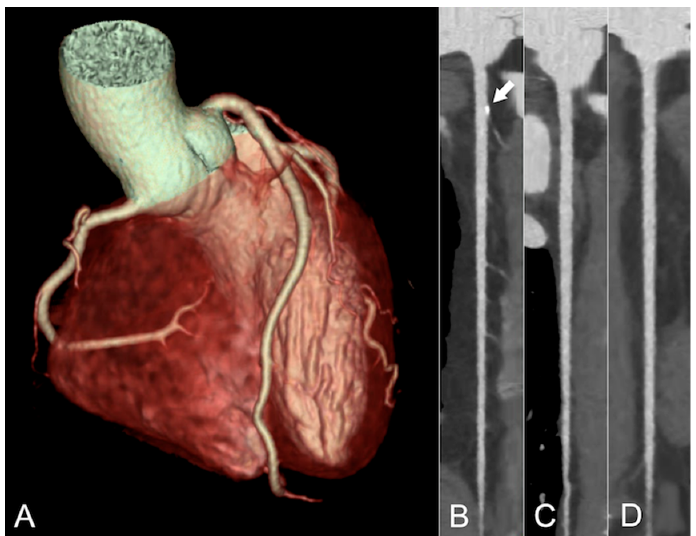
Figure 2. Coronary computed tomography angiography of a 48-year old HIV+ female patient with typical angina. The patient had a positive family history for cardiovascular events and was an active smoker, putting her at intermediate risk for having coronary artery disease. Volume rendering ( A ) of the image datasets depicts normal coronary anatomy, while the curved multiplanar reformats of the left anterior descending ( B ), the left circumflex ( C ), and the right coronary ( D ) arteries reveal only minimal and non-obstructive coronary atherosclerosis in the proximal left anterior descending (white arrow). Coronary artery disease was, therefore, excluded as a cause for her symptoms. BMI 24.2 kg / m 2 . Radiation dose exposure 0.57 mSv. Contrast volume 40 mL.